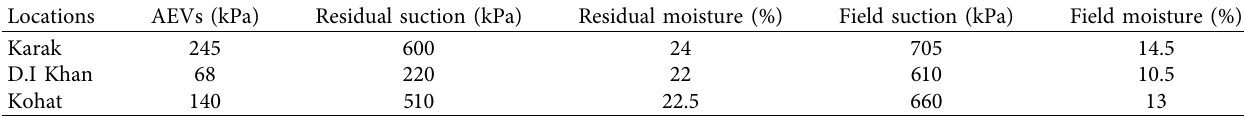
Table 5: Summary of the key parameters for the selected sites of expansive soils.